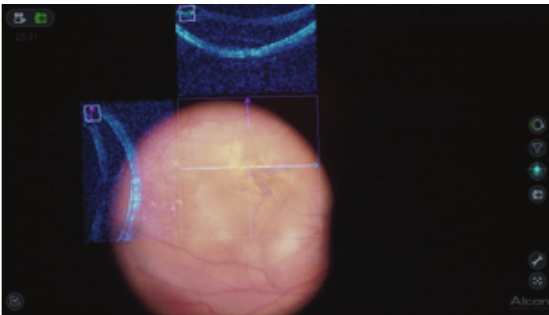
Figure 3. (A) Preoperative appearance, (B) partial resolution of the macular schisis one month postoperatively, and complete resolution of the schisis (C) four and (D) seven months after the surgery. Visual acuity improved from 20/200 to 20/40 and subfoveal macular thickness improved from 706 to 221 µm after seven months of